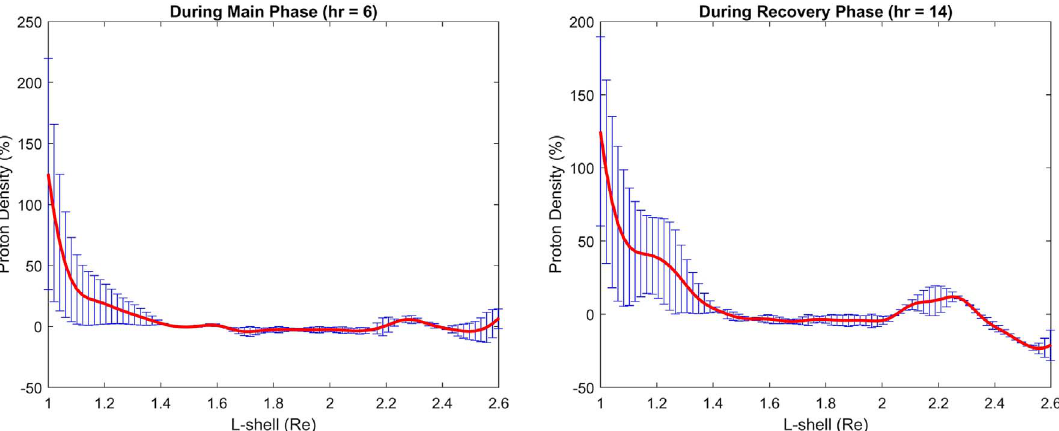
Fig. 8. The error bar shows the counting statistics of the inner proton belt density variations with respect to the initial storm phase (after 3 h from the beginning of the simulations) for different initial particle conditions. The densities were similarly calculated as in Figure 4.